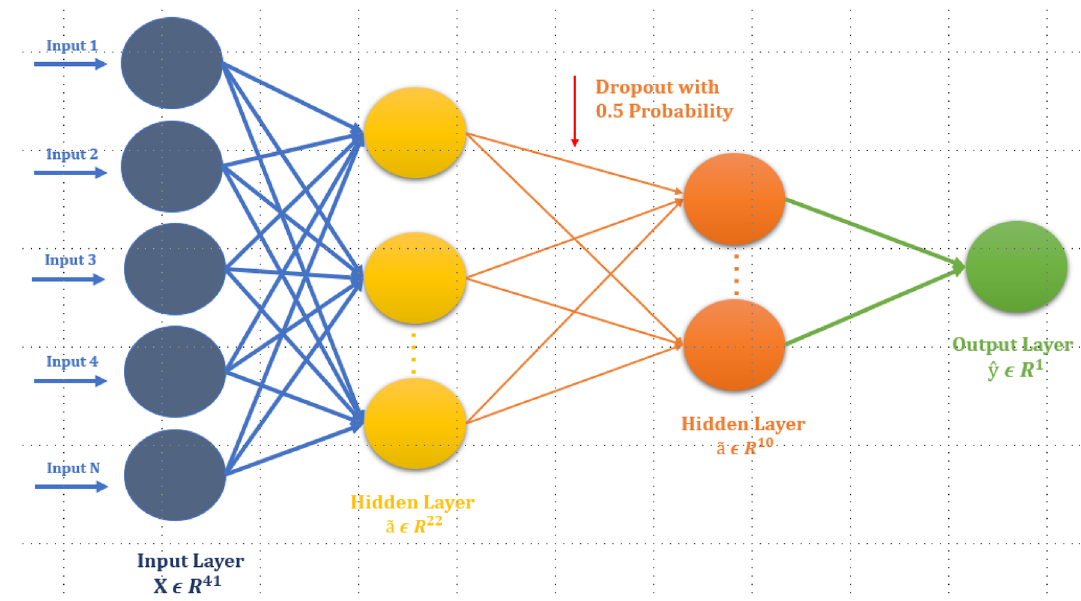
Figure 10. Architecture of FCN for CarboxE site identification.